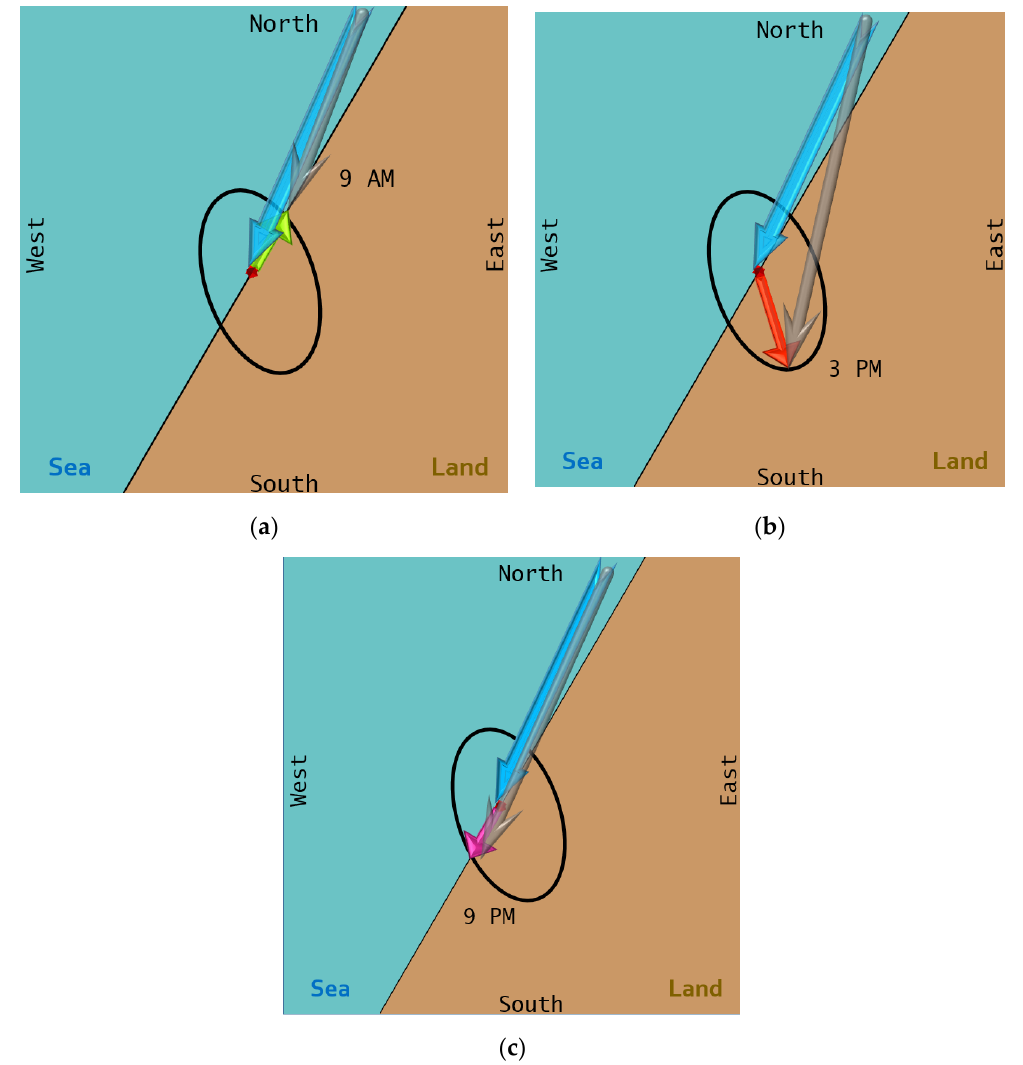
Figure 9. The blue arrows represent the northeast monsoon in winter. The land–sea breeze arrows rotate in the ellipse are shown with different colors for different times (9 AM, 3 PM, 9 PM) on a winter day. The gray arrows represent the wind speed resultant vectors composed of the land–sea breeze and the winter monsoon. ( a ) Resultant wind vector at 9 AM in December; ( b ) resultant wind vector at 3 PM in December; ( c ) resultant wind vector at 9 PM in December.